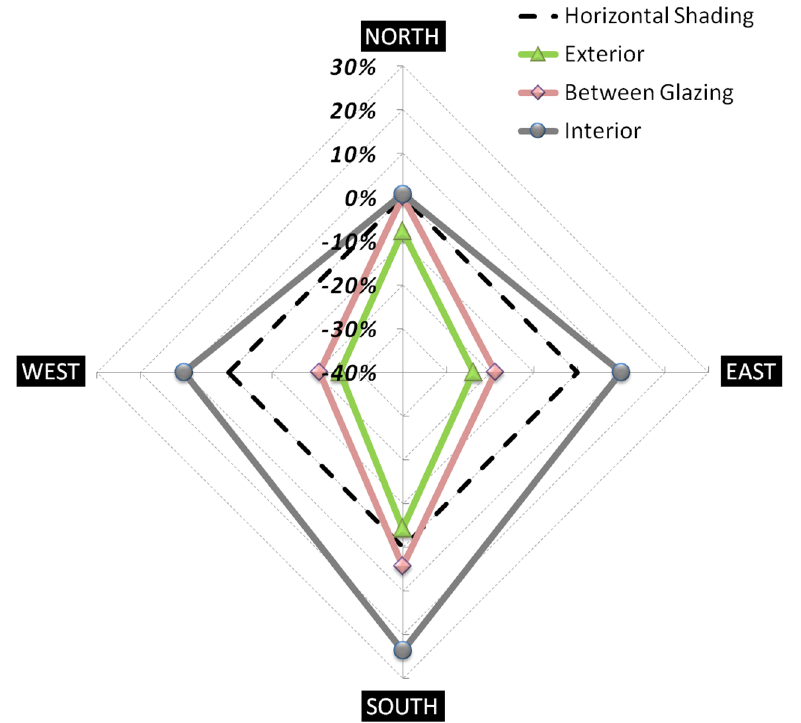
Figure 12. Saving ratio of the heating and cooling load according to the type of shading (WWR 80%, U-value: 2.1, SHGC: 0.4).